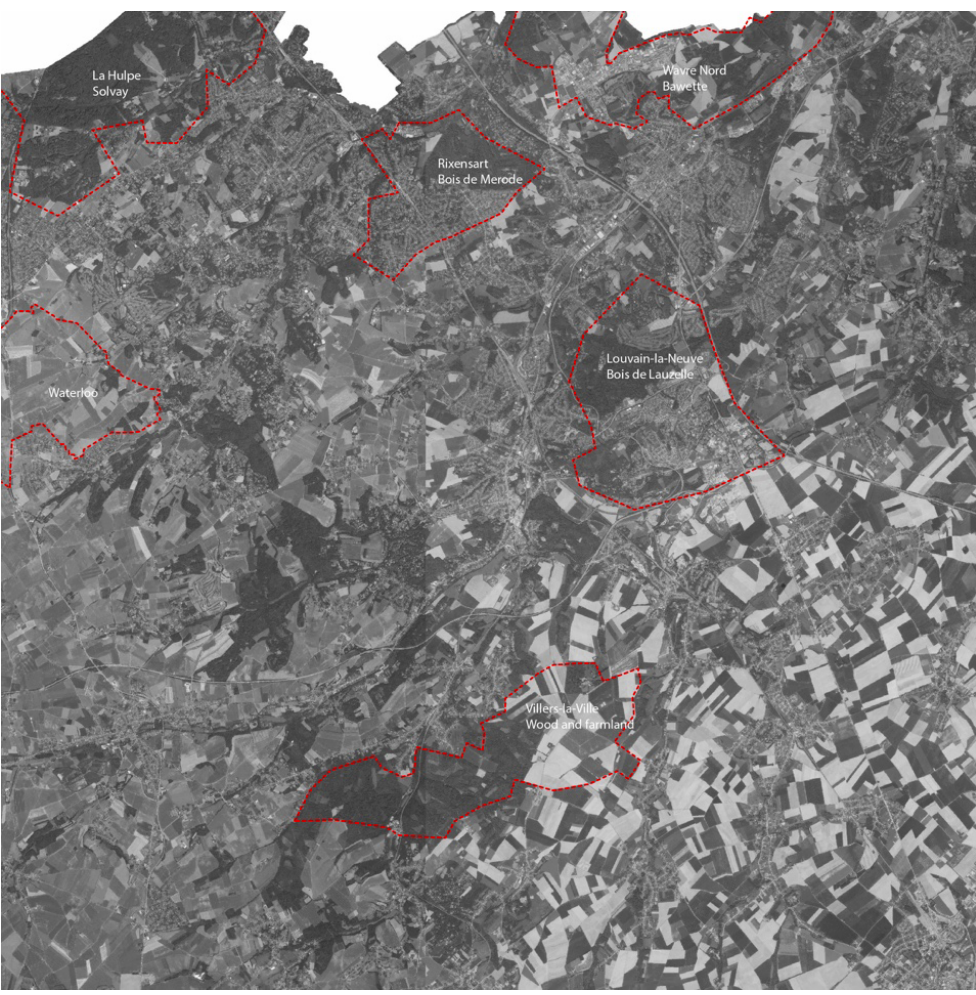
Figure 1. Selection of former noble large land holdings in Walloon Brabant, square of 20 × 20 km. Drawing by the au- thor based on Popp [ca. 1854], Meuwissen (1994), the lotissements dataset (SPW-DG04, 2020) and the orthophotoplan (SPW-DG04,